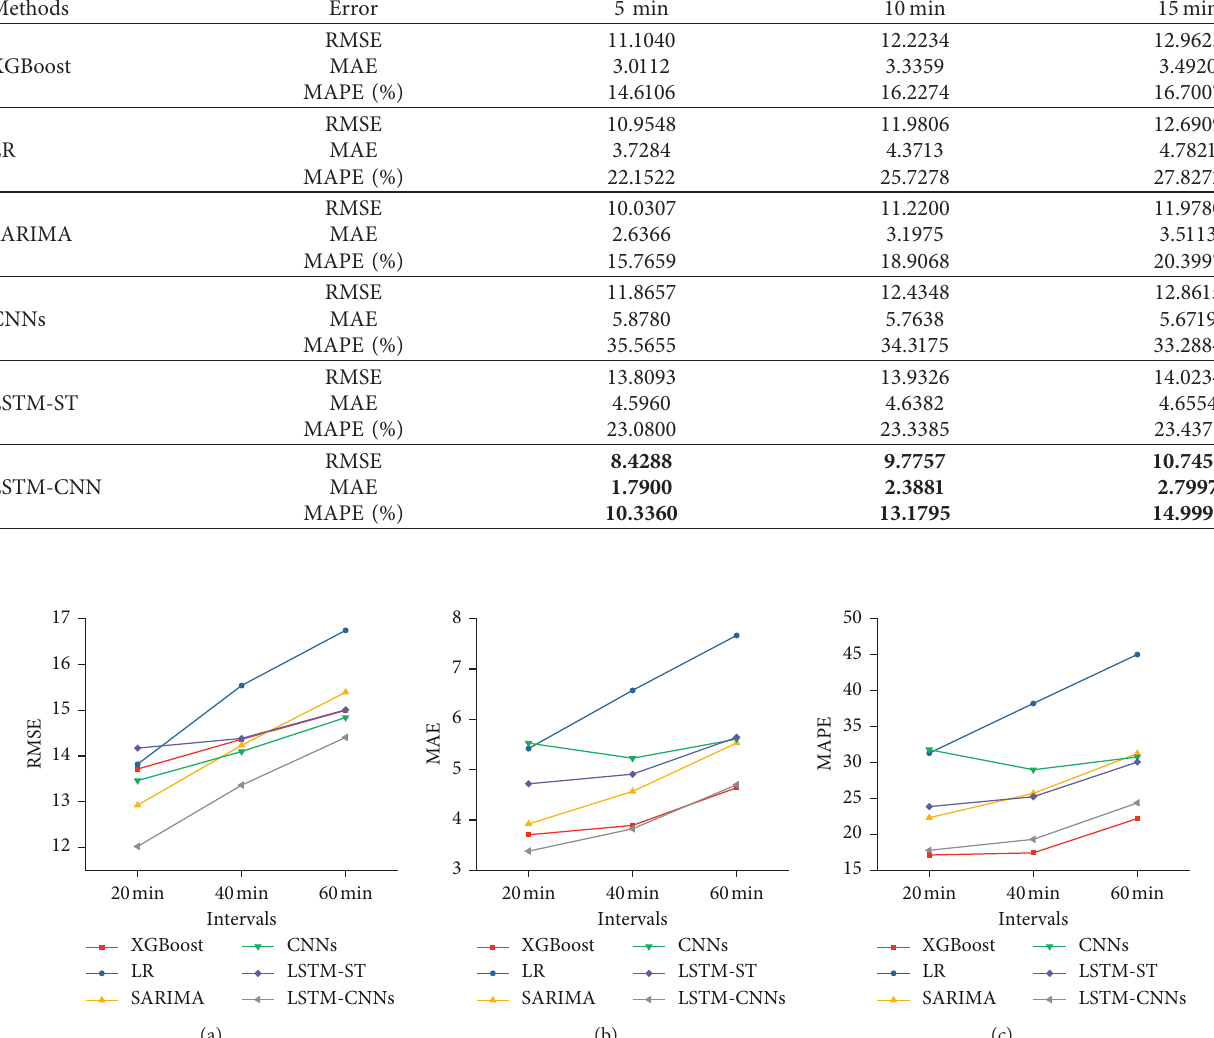
Table 8: Short-term prediction error results of different methods.